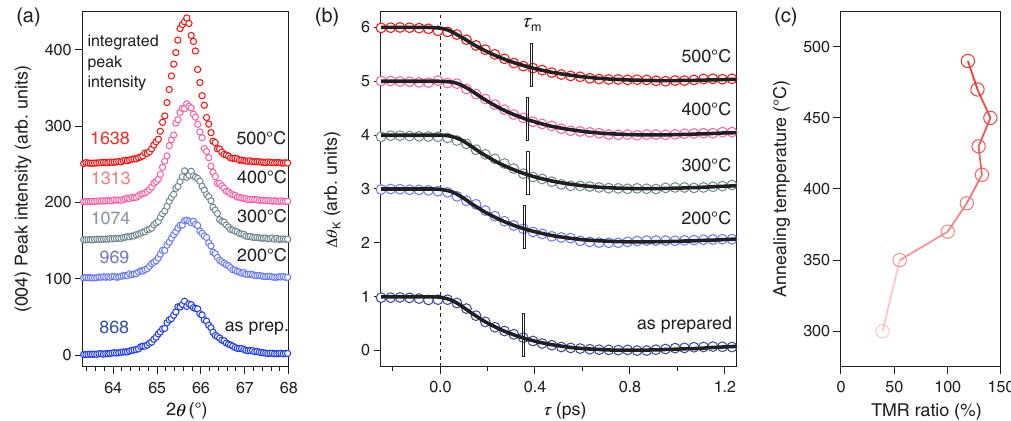
FIG. 1. Film optimization. Annealing temperature dependence of Co (b) shows the demagnetization time (vertical bar marks the value of (cid:1) m ), the lines are fits using an analytical function derived from a three-temperature model, and (c) exhibits the TMR of the Co